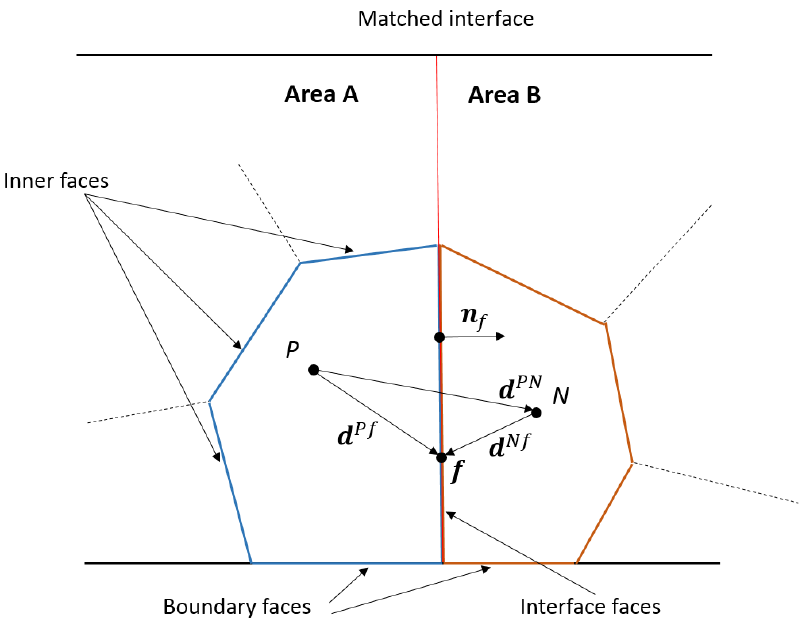
Figure 1. Schematic example of a grid with matched inner interfaces. corrected for nonorthogonality [21]. The value of gradient ∇ ϕ n